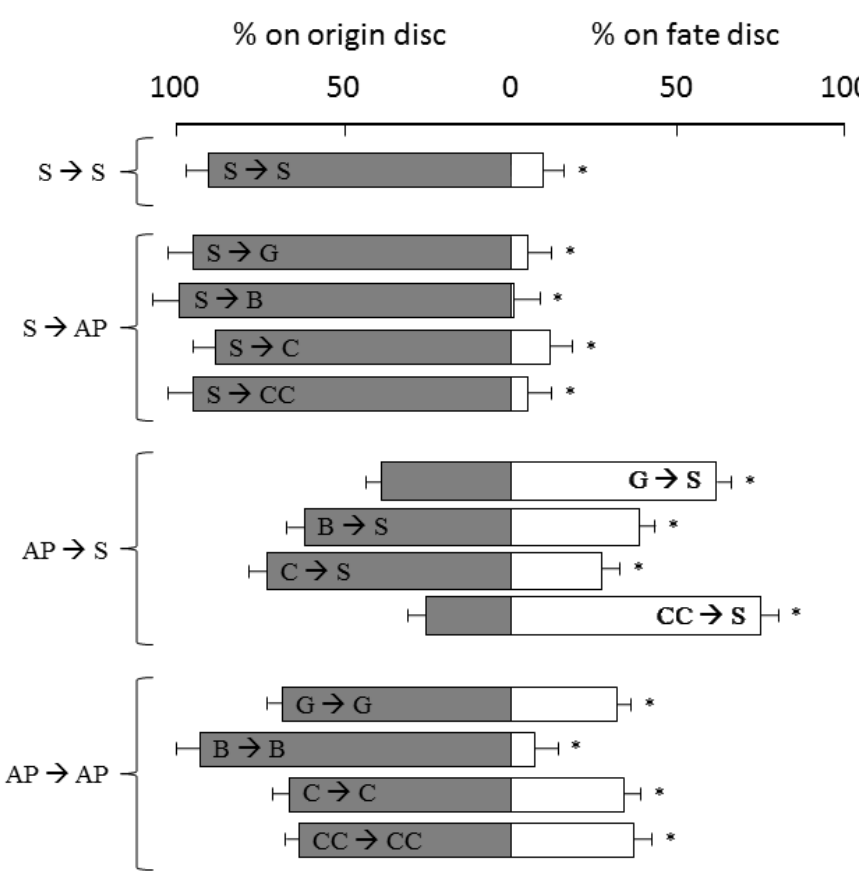
Table 2. Number of eggs laid by Tetranychus urticae females on first five days (EFD), total number of eggs (TNE), eggs per day (EPF), and female longevity (LON) (days) means (± Standard deviation) in